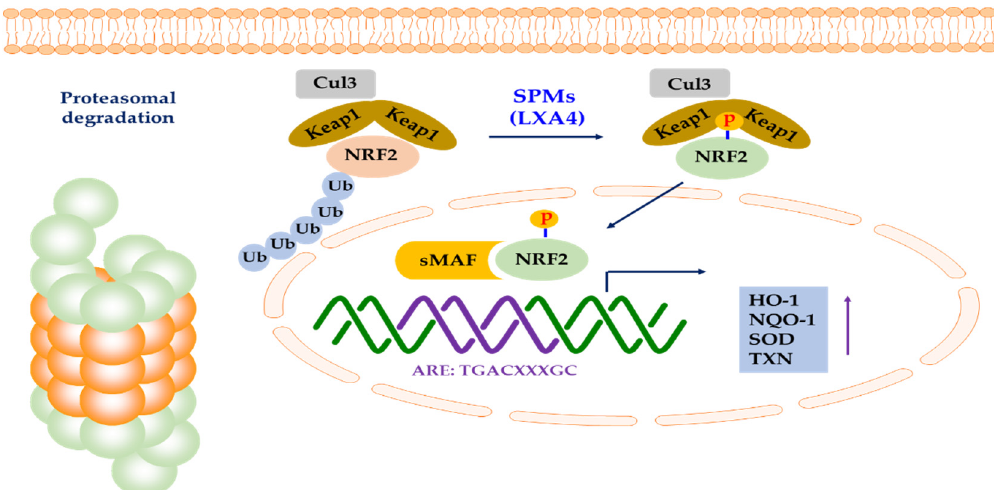
Figure 4. Activation of NRF2 by SPMs. LXA4 can activate NRF2 by inducing the phosphorylation of Ser40 of NRF2 to induce nuclear translocation. Phosphorylated NRF2 can form a heterodimer